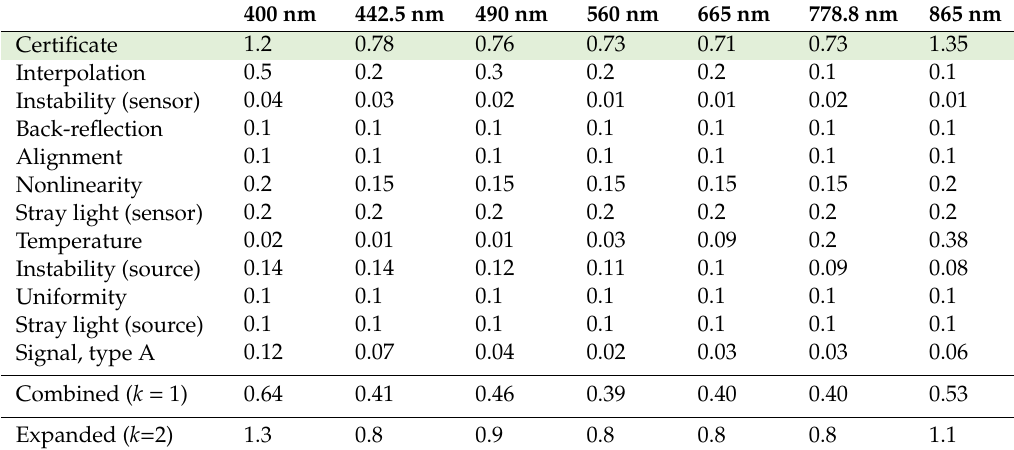
Table 4. Relative uncertainty budget for the radiance (in percent) based on spread of individual sensors measuring the same integrating sphere during indoor comparison. Data highlighted in green are not used for combined and expanded